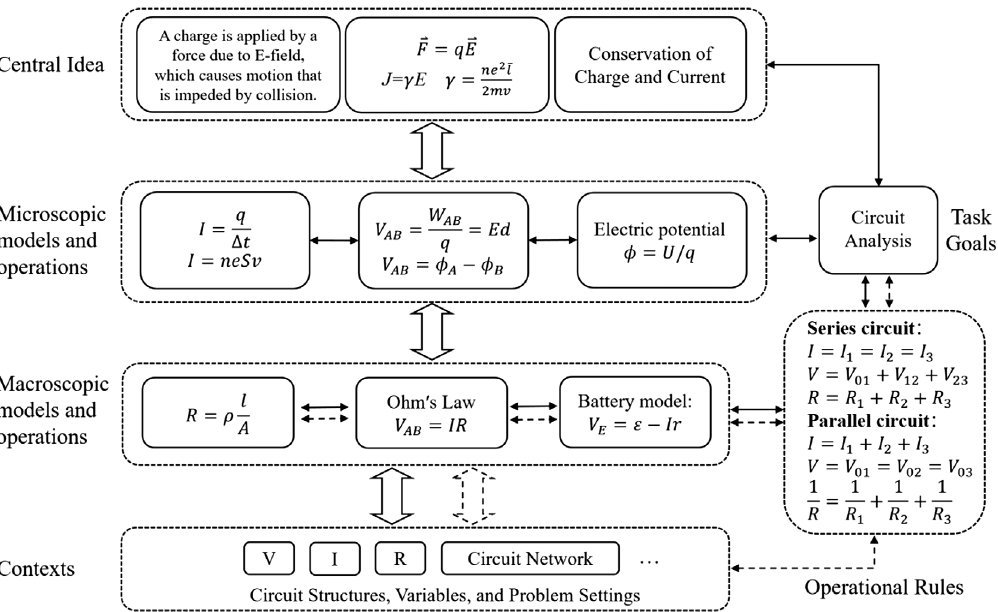
FIG. 1. The conceptual framework model of electric circuits. The solid arrows represent the conceptual pathways of experts, and the dashed arrows represent the conceptual pathways of novice students. Intermediate level students often have mixed use of expert and novice